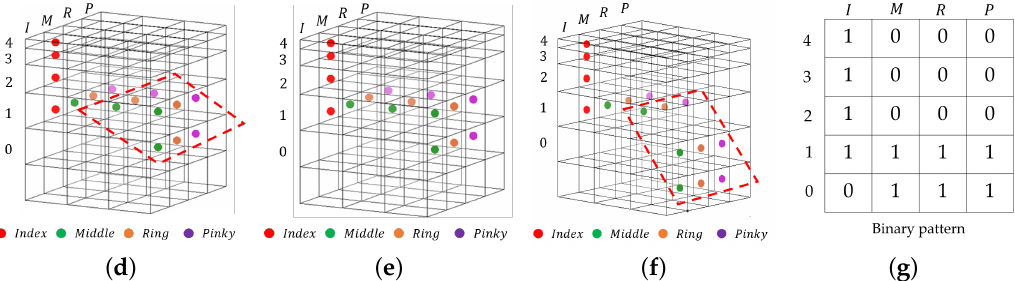
Figure 6. Comparison of a hand pointing pattern in different postures: ( a ) Hand pointing in origin posture with coordinates, ( b ) Hand pointing in rotated posture, ( c ) Hand pointing with slight changes, ring, and pinky finger, ( d ) 3D binary pattern of ( a ), ( e ) 3D binary pattern of ( b ), ( f ) 3D binary pattern of ( c ), and ( g ) Two-dimensional (2D) binary patterns of ( a , c )